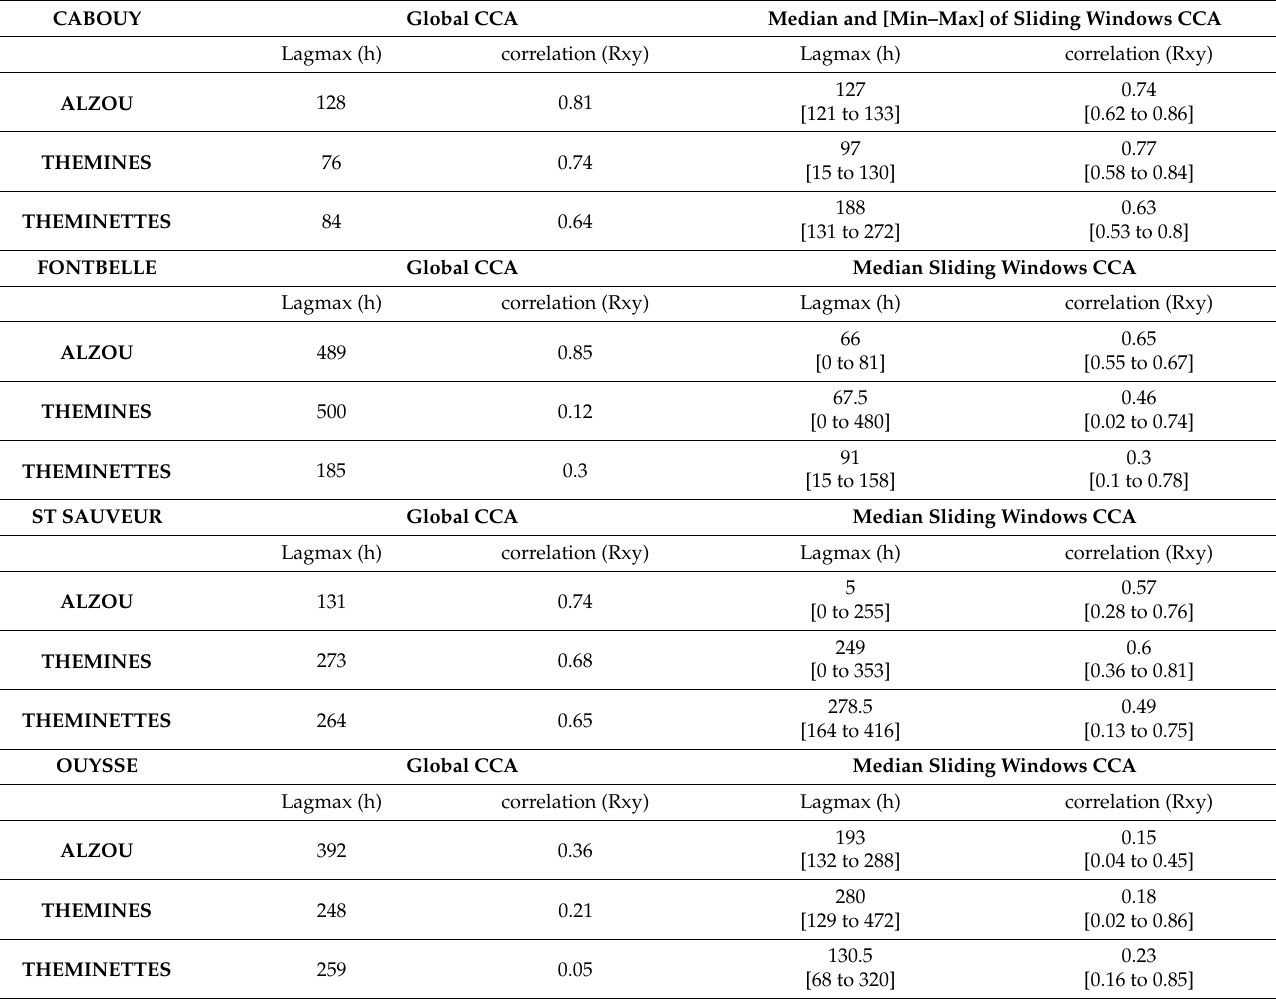
Table 3. Compared results of the global ACC and the sliding window ACC between sinks’ electrical conductivity and springs’ electrical